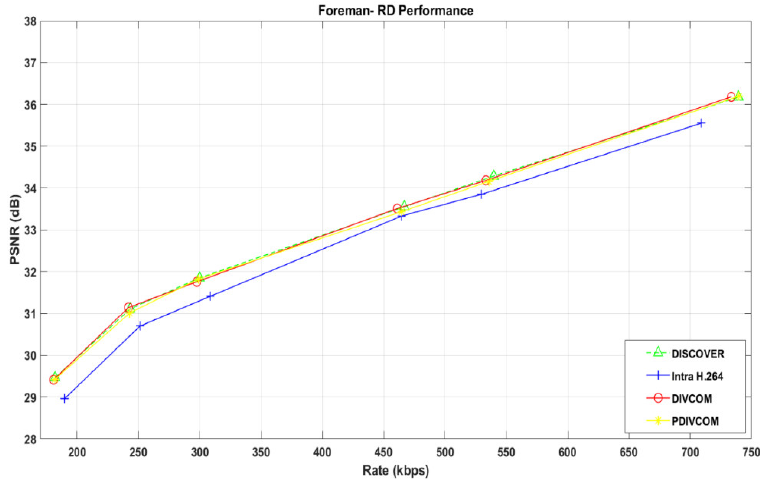
Figure 4. Rate-distortion (RD) performance graphical evaluation of “Foreman” test video sequence with frame rate of 15 Hz and GOP 2.